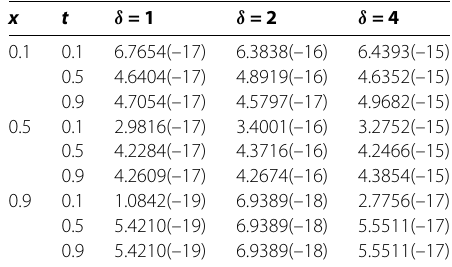
Table 10 Example 4: Case 4.1: Maximum absolute errors